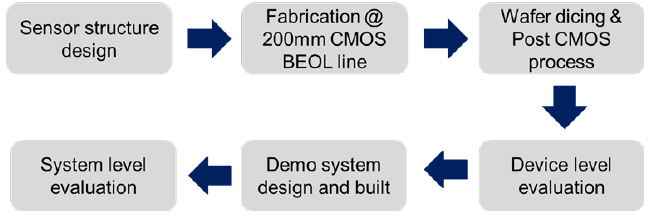
Figure 1. Workflow of this study.